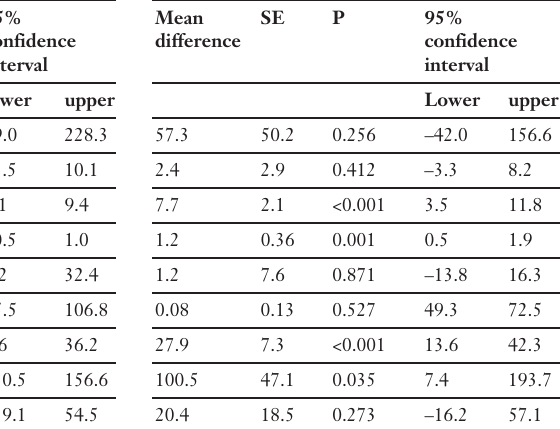
Significant differ- ences between boys and girls or over- weight and normal weight children in the intake of macronutrients and food